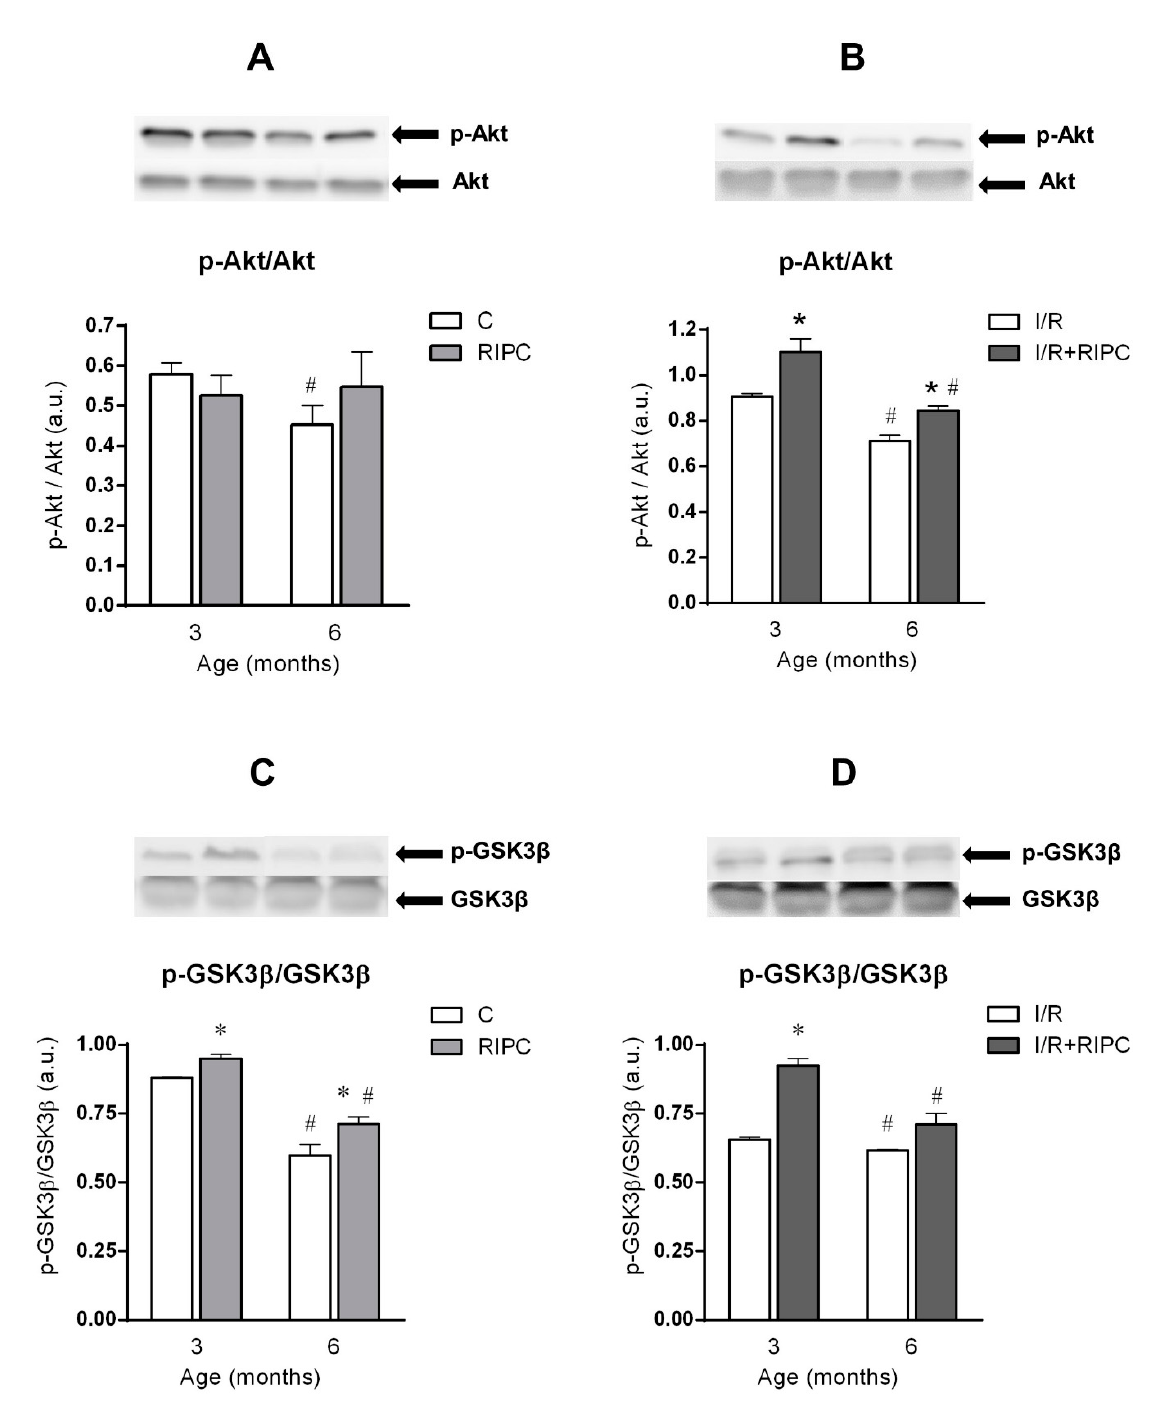
Figure 2. The effect of age and remote ischemic preconditioning on the expression of selected signaling pathway proteins in rat myocardium at the baseline condition ( A , C ) and after ischemia/reperfusion ( B , D ). Samples were taken prior to ischemia (after 20 min stabilization perfusion) and at 40 min of post-ischemic reperfusion. Akt—protein kinase B, p-Akt—phosphorylated (activated) Akt, GSK3 β —glycogen synthase kinase 3 beta, p-GSK3 β —phosphorylated (inactivated) GSK3 β . The phosphorylation (activation) of Akt was expressed as the ratio of p-Akt and total Akt. The phosphorylation (inactivation) of GSK-3 β was expressed as the ratio of p-GSK3 β and total GSK3 β . C—baseline samples, I/R—post-IR samples, RIPC—samples with prior remote ischemic preconditioning. Data are presented as means ± S.E.M of 4–5 hearts per group, normalized to the levels of GAPDH. * p < 0.05 RIPC vs. C; # p < 0.05 vs. 3